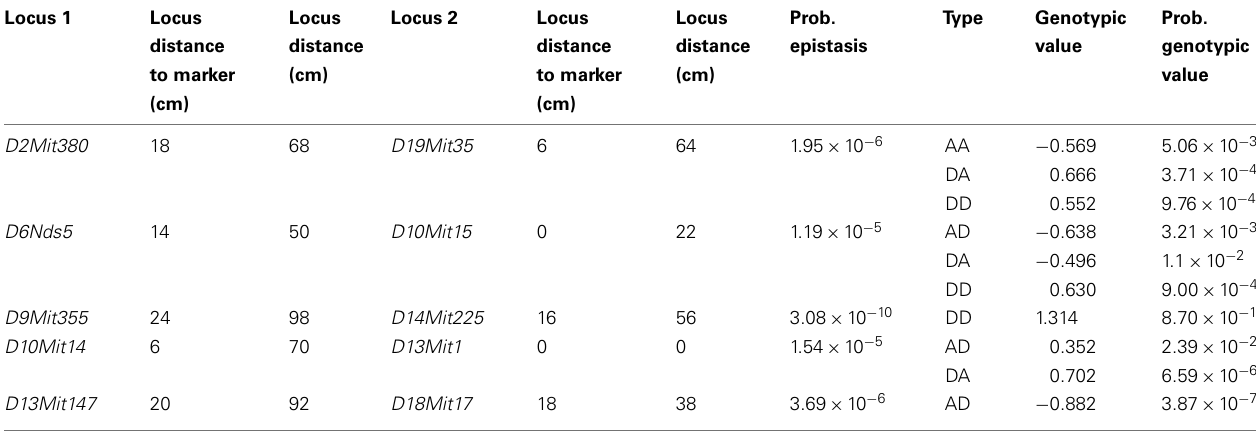
TableA6 | Epistatic QTLs of postpartum temperature difference in F 2 females. Locus 1 Locus